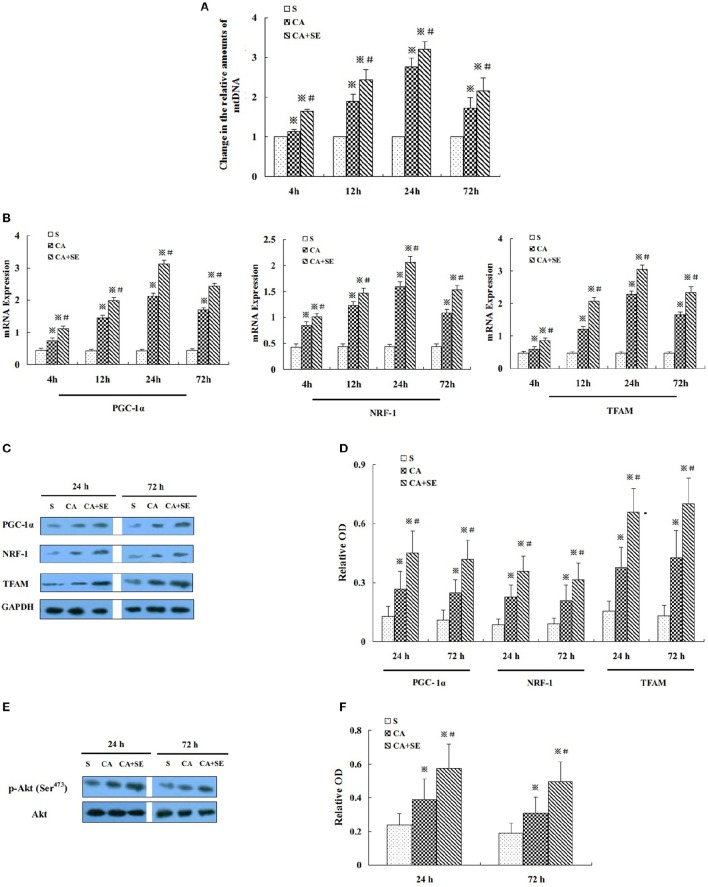
Effect of sevoflurane post-conditioning on hippocampal neuronal mitochondrial biogenesis after global cerebral ischemic injury. (A) The relative amounts of hippocampal mtDNA were measured using quantitative real-time PCR in three groups. (B) The histogram shows the quantitative measurement of real-time PCR products of mitochondrial biogenesis factors obtained using densitometric analysis. (C) Western blot images for PGC-1ɑ, NRF-1, and TFAM in rats in the presence and absence of sevoflurane; (D) Quantitative analysis of PGC-1ɑ, NRF-1, and TFAM expression levels. (E) Western blots analysis for p-Akt in the hippocampus of different group at 24 and 72 h after reperfusion. (F) Quantitative analysis for the level of p-Akt in thehippocampus. Data are expressed as mean ± S.D. n = 6–8 rats for each group. ※P < 0.05 vs. the sham group; #P < 0.05 vs. the CA group.